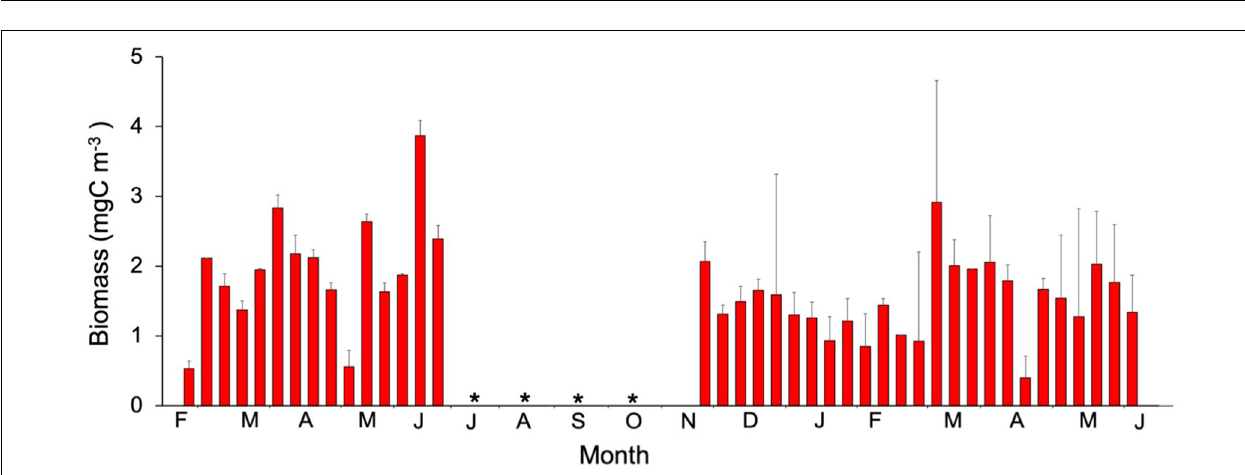
ocean (e.g., Armengol et al., 2019). Outside the productive period during 2011, dinoflagellates also predominated in the microplankton community as previously observed in the